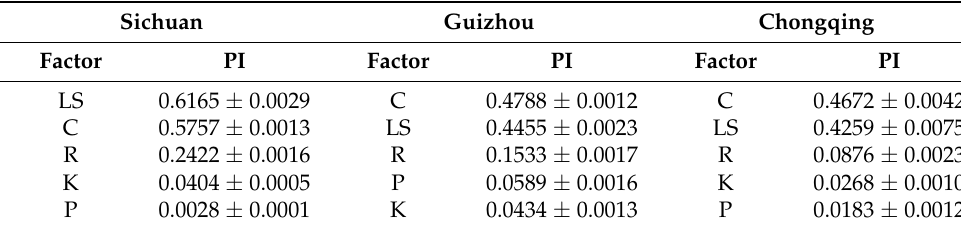
Table 5. Ranking of factor